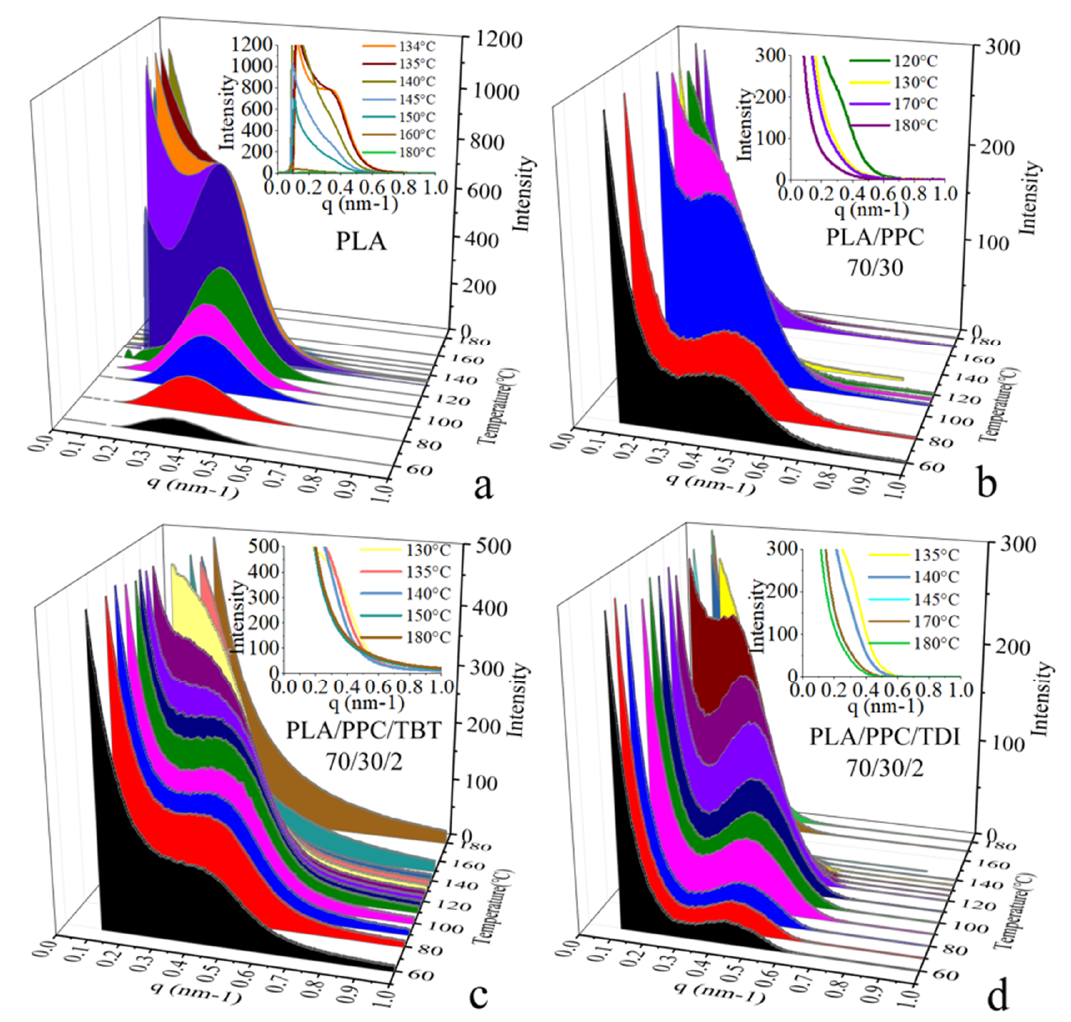
Figure 6. Selected in situ SAXS profiles during a cooling process at 4 °C/min of PLA ( a ), PLA70/PPC30 blend ( b ), PLA70/PPC30/TBT2 blend ( c ) and PLA70/PPC30/TDI2 blend ( d ).